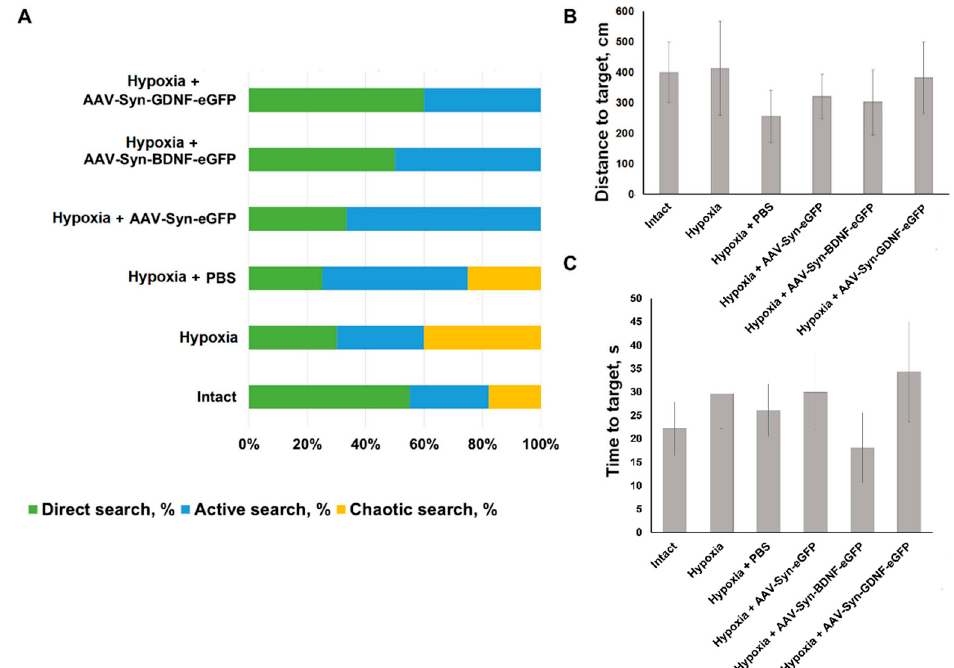
Figure 6. Representative confocal images of ICC of mouse brain slices on day 7 after acute hypobaric hypoxia modelling: “Intact”, “Hypoxia”, “Hypoxia + AAV-Syn-BDNF-eGFP”,”Hypoxia + AAV- Syn-GDNF-eGFP”. Blue—DAPI, Green—NeuN, Orange—GFAP, Red—MAP2. Odd rows-scale bar–100 µm (Plan-Apochromat 10×/0.3 objective). Even rows -scale bar–20 µm Plan-NeoFluar 40×/0.75 objective. A laser scanning microscope LSM 800 (Zeiss, Oberkochen, Germany) was used for the imaging.